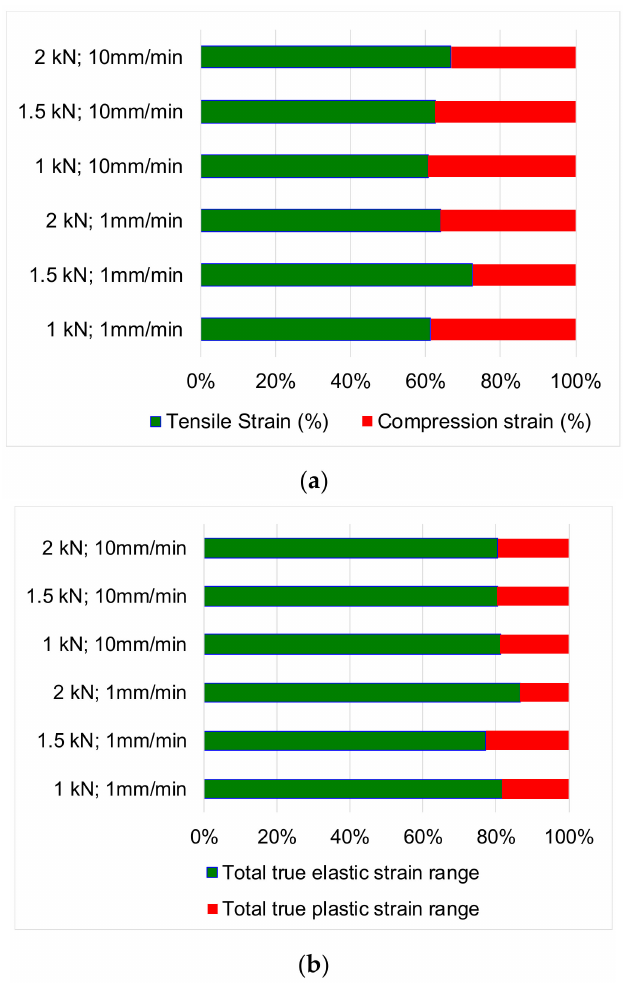
Figure 8. Comparison of strains in cases of di ff erent load speeds and intensity: ( a ) tensile and compression strains; ( b ) total true elastic and plastic strain range after a complete cycle.